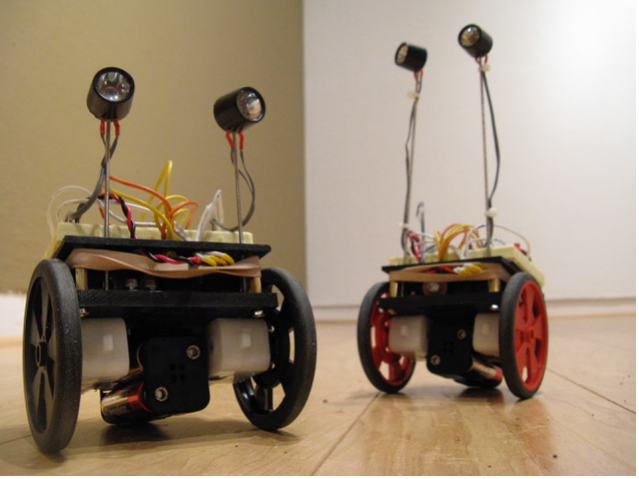
Figure 1. Steve Daniels, Whimsy, 2008. Image courtesy of the